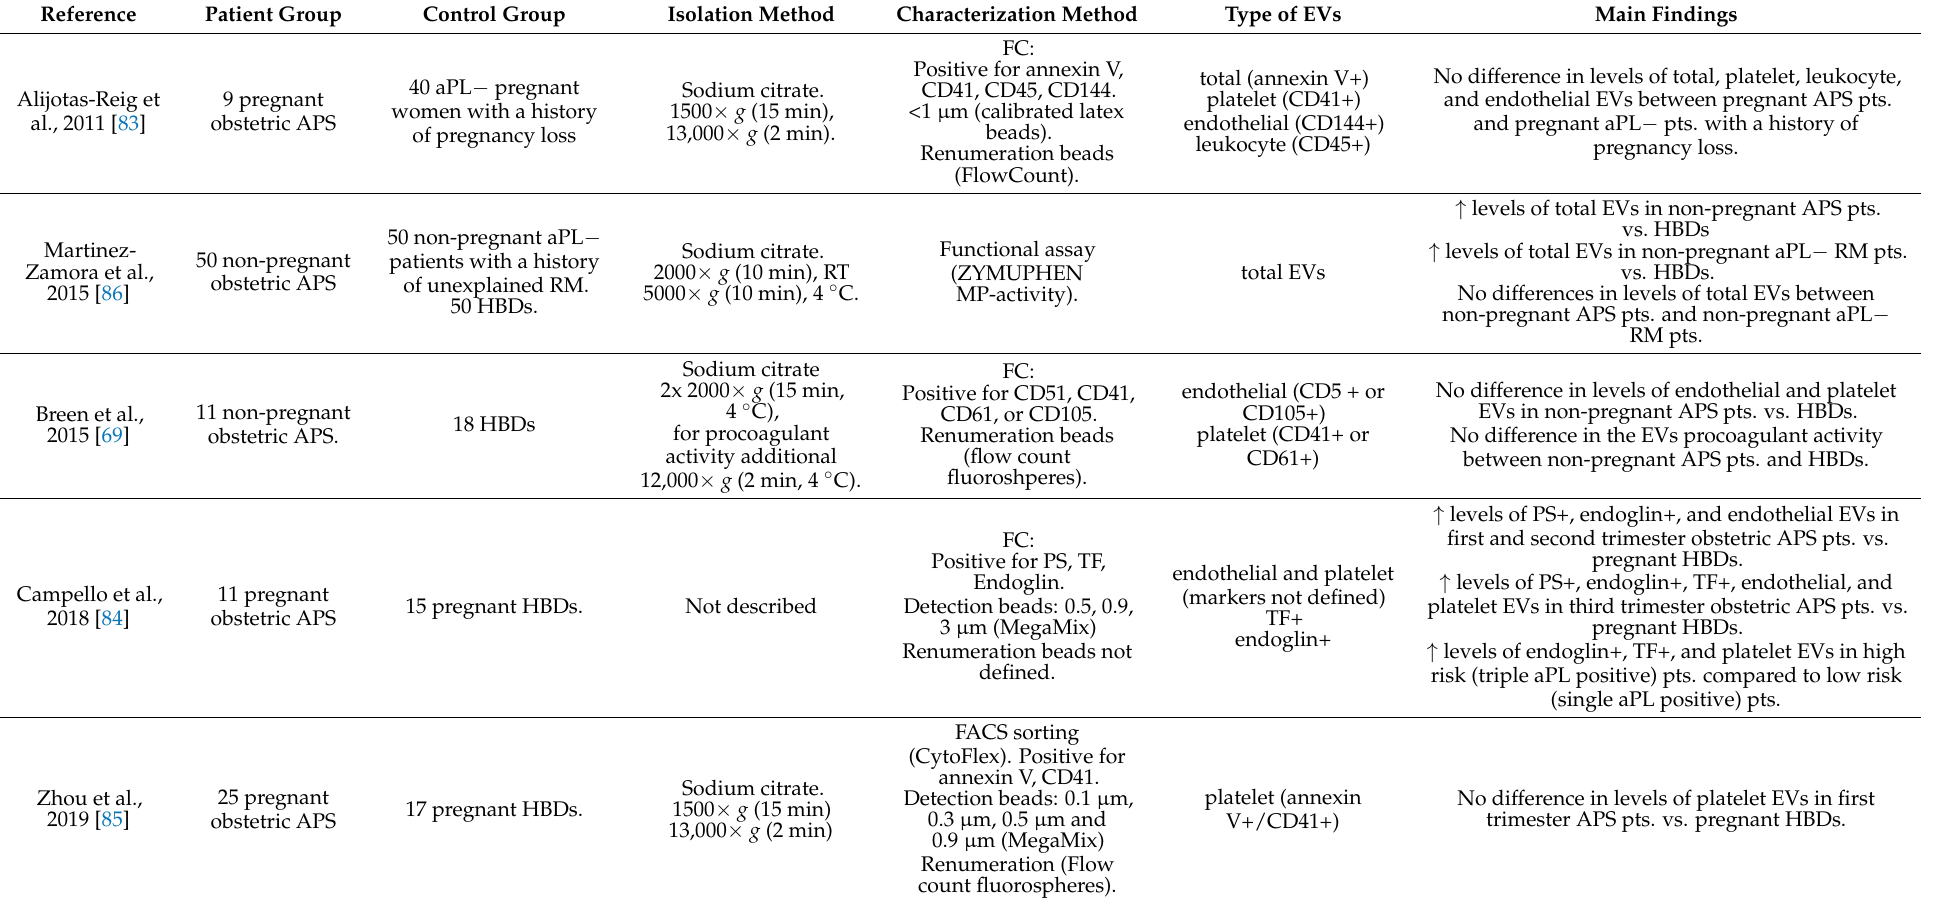
Table 3. Isolation, quantification and characterization of EVs in plasma of obstetric APS